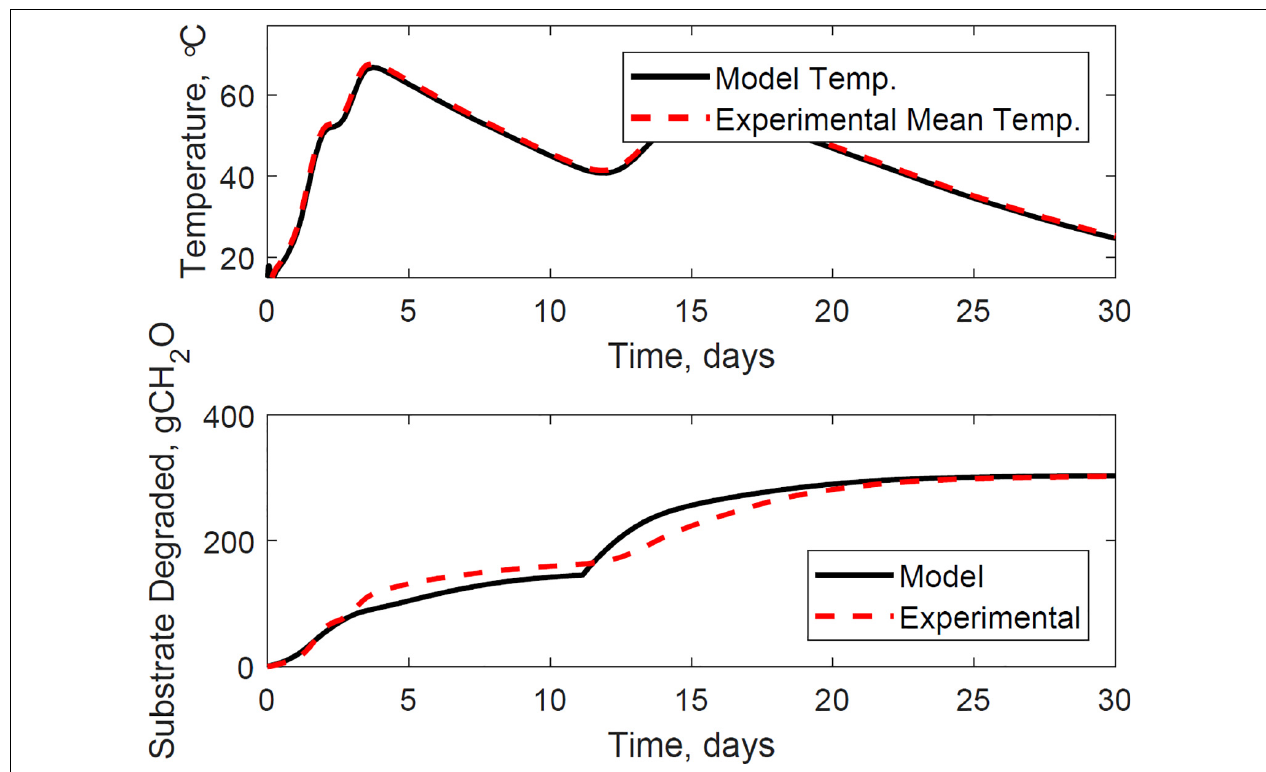
FIGURE 9 | Reactor 1 temperature (top) and substrate degraded (bottom) validation of system dynamics model. The model inputs are 365 cc.min − 1 airflow rates, 31% initial moisture content, 15% final moisture content, 24 ◦ C ambient temperature. The initial model conditions are 10.6 ◦ C and 6456 g. The temperature mean absolute error is 1.2 ◦ C, and the dry matter loss relative error is